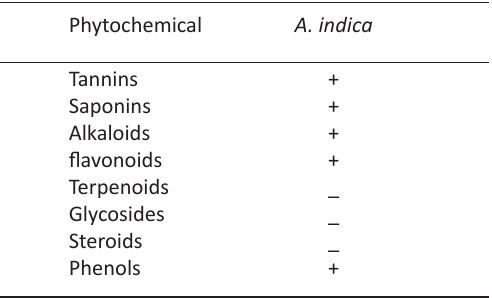
Table 4 . Phytochemical analysis in A. indica crude extract